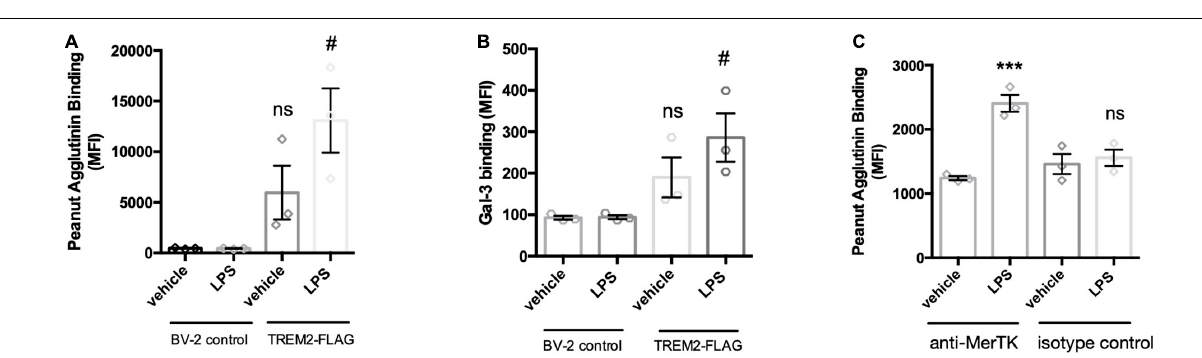
FIGURE 6 | LPS-mediated activation of BV-2 induces removal of sialic acid residues from TREM2 and MerTK receptor. TREM2-FLAG or control BV-2 were treated with vehicle or LPS (100 ng/ml 18 h). Cells were lysed and FLAG-tagged TREM2 captured by anti-FLAG antibody. MerTK was captured on the beads by an anti-MerTK antibody (or appropriate isotype control antibody to control for non-specific binding). Antibodies were captured by protein A/G magnetic beads and subjected to PNA-FITC or Gal-3-TAMRA lectins. (A) Binding of PNA-FITC or (B) Gal-3-TAMRA to FLAG pull downs from LPS-treated control or TREM2-FLAG-expressing cells. Data presented as mean fluorescence intensities ± S.E.M. Statistics: paired t-tests, # p < 0.05 versus TREM2-FLAG + vehicle, ns: non-significant versus BV-2 control + vehicle. (C) Binding of PNA-FITC to MerTK pull-downs from LPS- or vehicle treated BV-2 microglia. Data presented as mean fluorescence intensities ± S.E.M. Statistics: one-way ANOVA followed by Dunnett’s multiple comparison test, *** p <